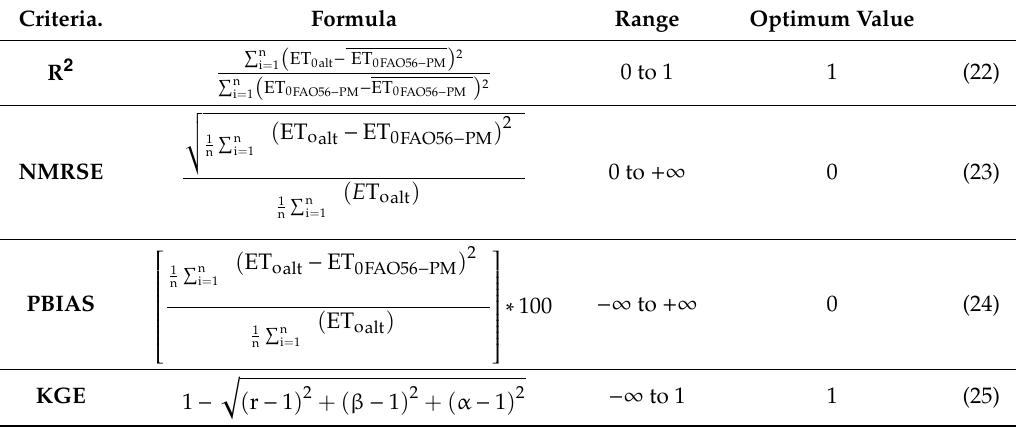
Table 3. Range and optimum value of the evaluation criteria. Criteria.